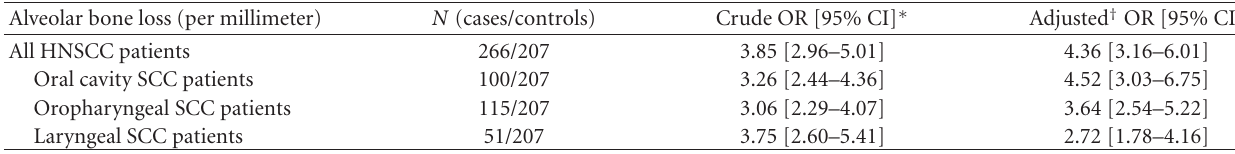
Table 3: Association between periodontitis and head and neck cancer stratified by tumor site ( N =